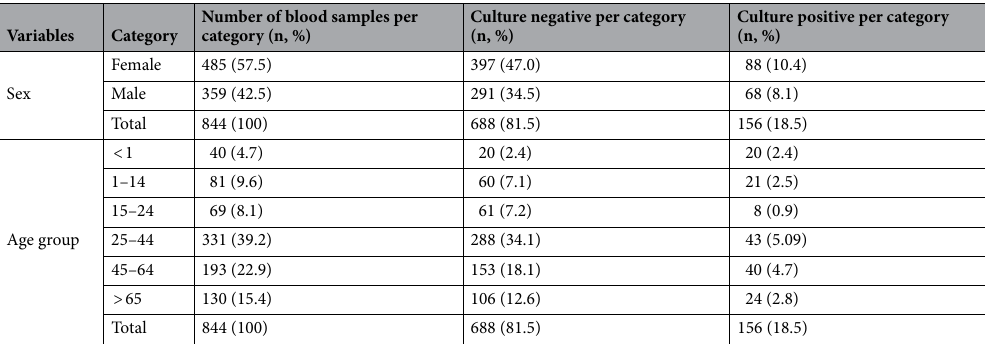
Table 1. Demographic characteristics and bloodstream infection per different categories of patients (844).